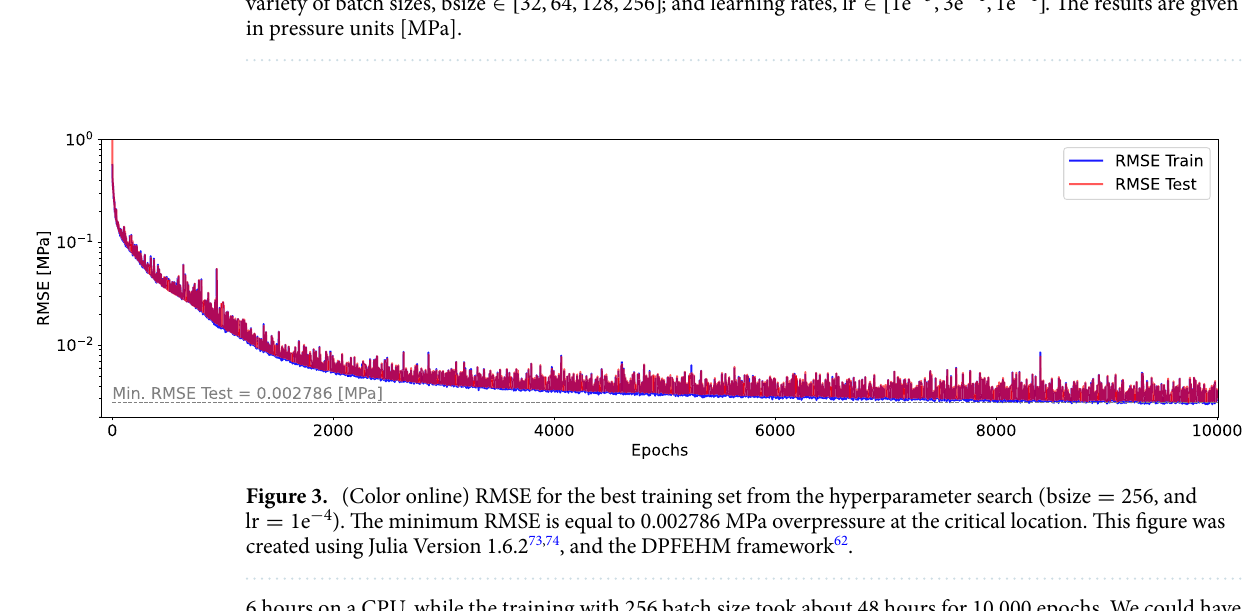
Figure 3. (Color online) RMSE for the best training set from the hyperparameter search ( bsize = 256 , and lr = 1e − 4 ). The minimum RMSE is equal to 0.002786 MPa overpressure at the critical location. This figure was created using Julia Version 1.6.2 73,74 , and the DPFEHM framework 62